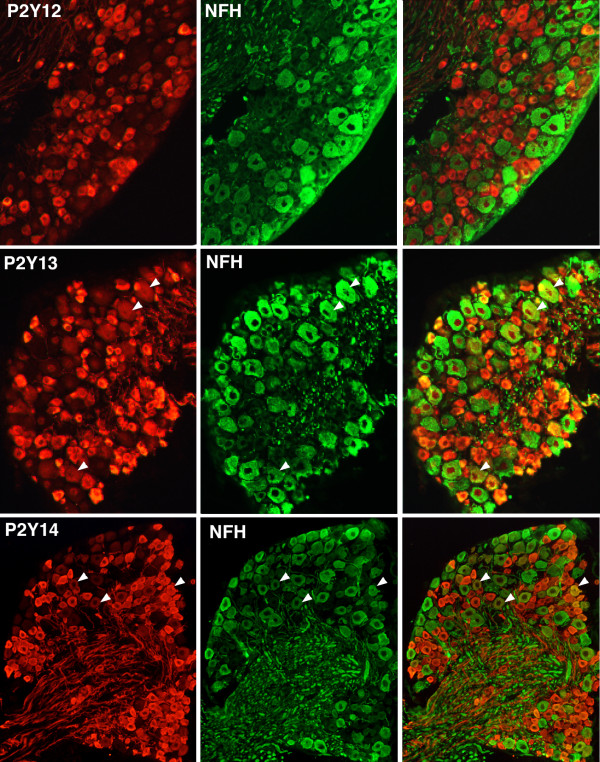
P2YGi receptor immunoreactivity is localized in sensory neurons of the DRG. Staining for P2Y12 (A), P2Y13 (B) and P2Y14 (C) in cryostat sections of DRG neurons double-labeled for the high-molecular weight neurofilament protein, NFH, used as a marker of neurons with myelinated axons. Antibodies for all three receptors intensely stain small-diameter, NFH-negative neurons. However, P2Y12 expression is largely restricted to NFH-negative neurons, whereas P2Y13 and P2Y14 are expressed in some NFH-positive sensory neurons (arrowheads). n = 3 mice, > 400 cells/antibody.